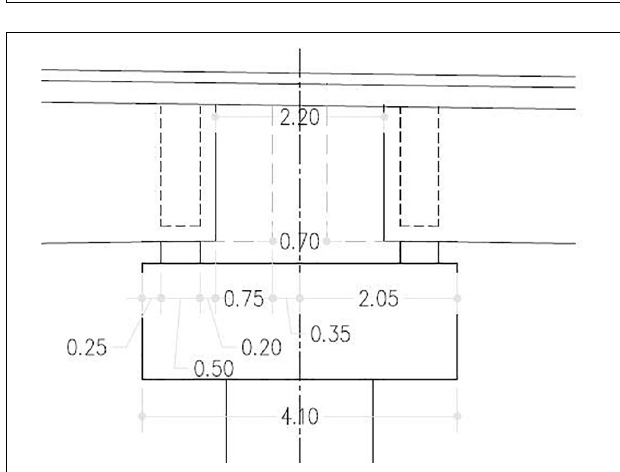
FIGURE 6 | Schematic representation of typical consecutive beams positioning (dimensions in